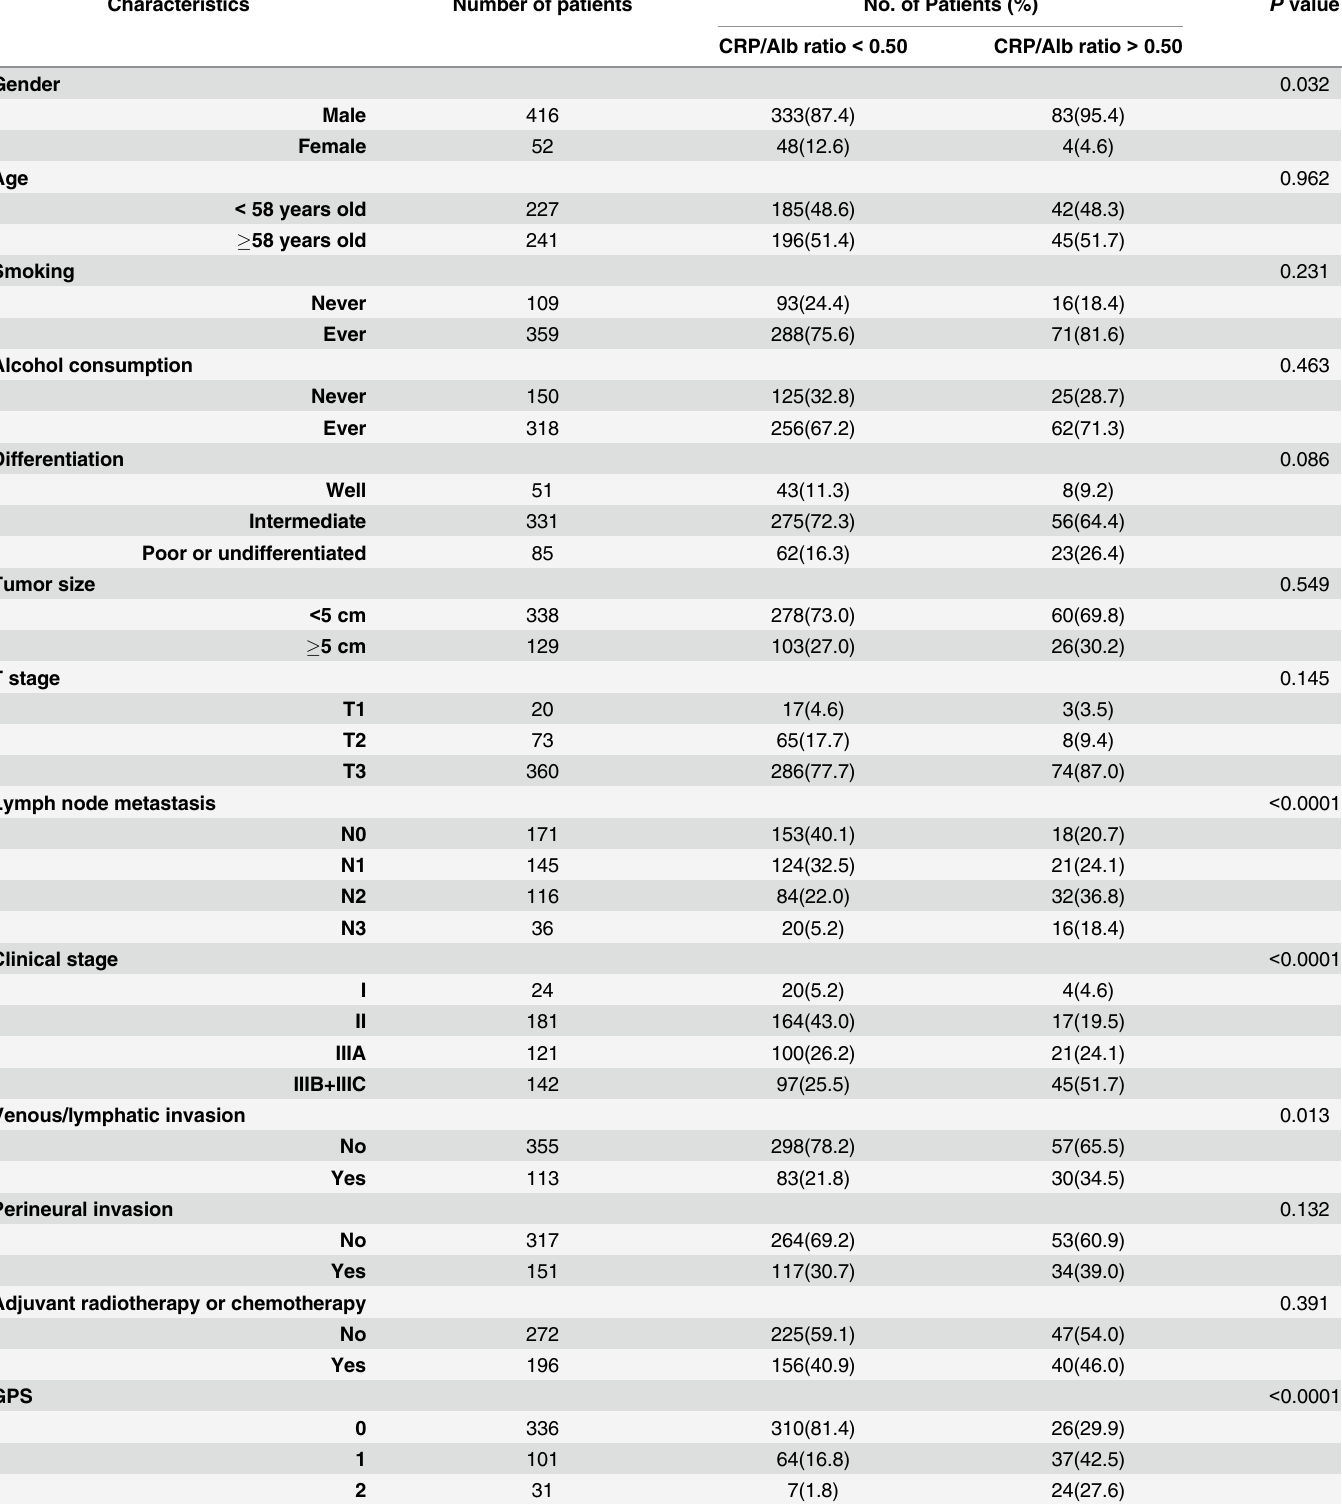
Table 1. Correlation of the CRP/Alb ratio with the clinicopathological characteristics of ESCC patients.